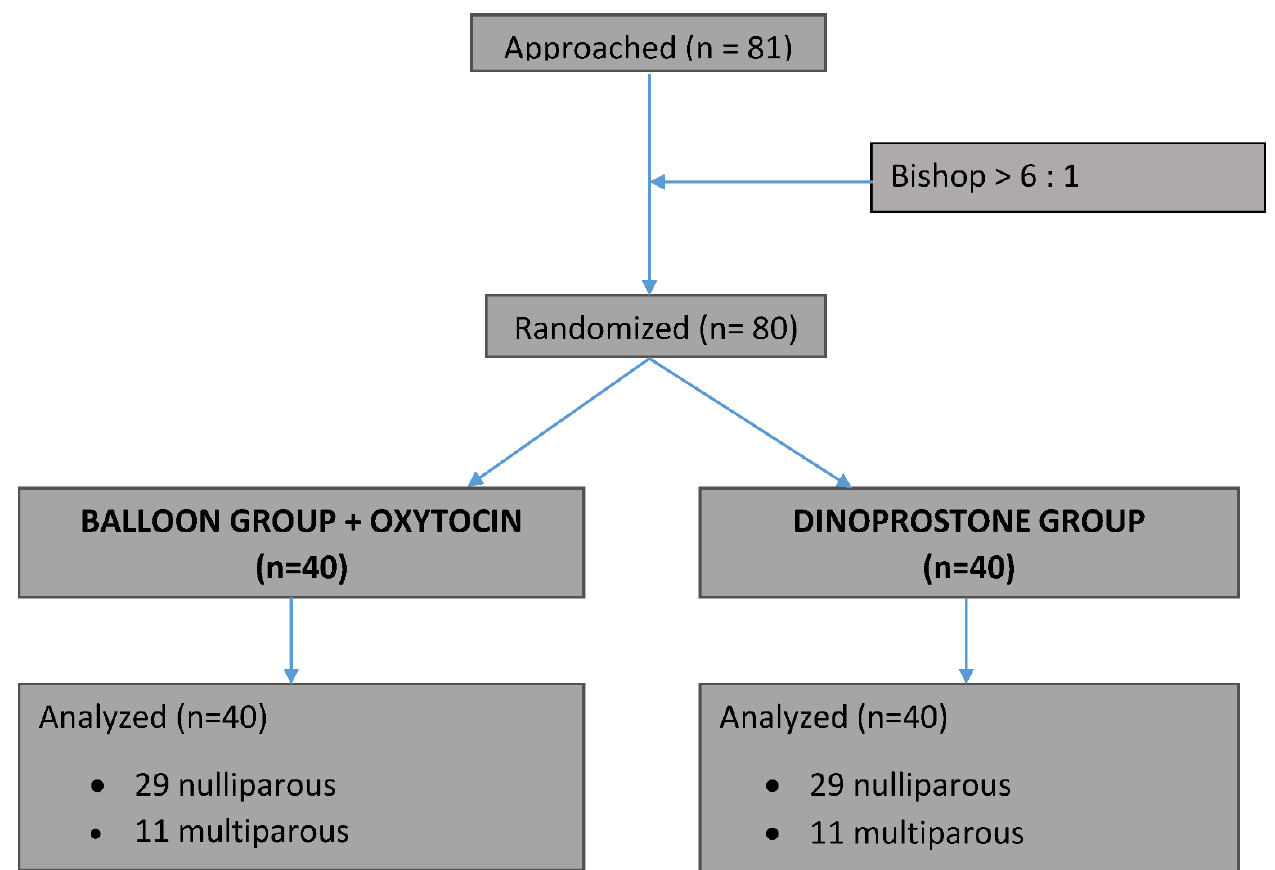
Figure 2. Flowchart of randomization into treatment groups.